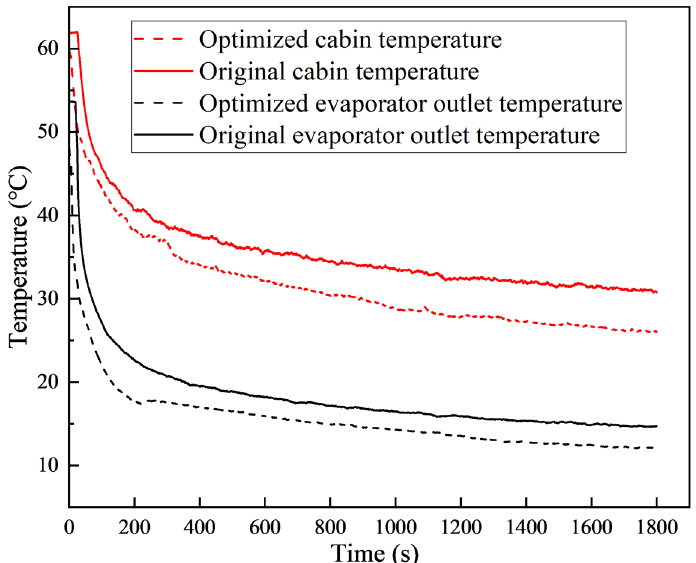
Figure 12. HVAC performances after reflux optimization.